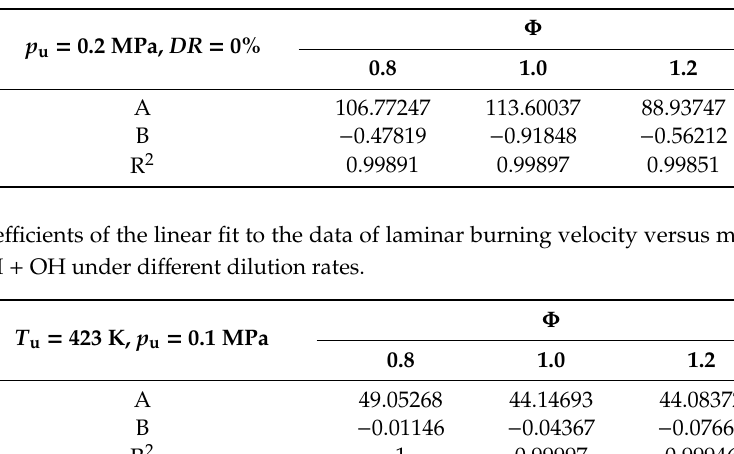
Table 5. Coe ffi cients of the linear fit to the data of laminar burning velocity versus maximum mole fraction of H + OH under di ff erent initial temperatures.